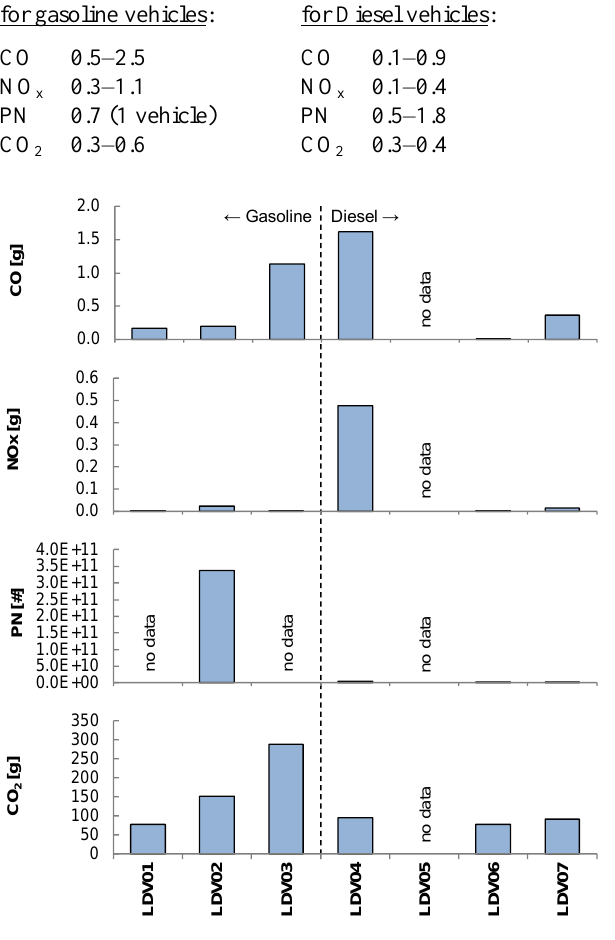
Fig. 11. Cumulated emissions at idling